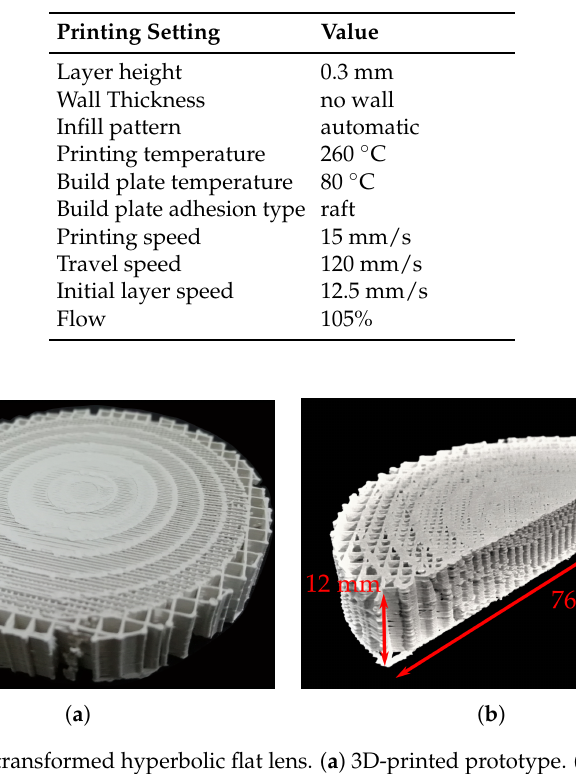
Table 3. 3D-printer settings for ABS1200 printing.